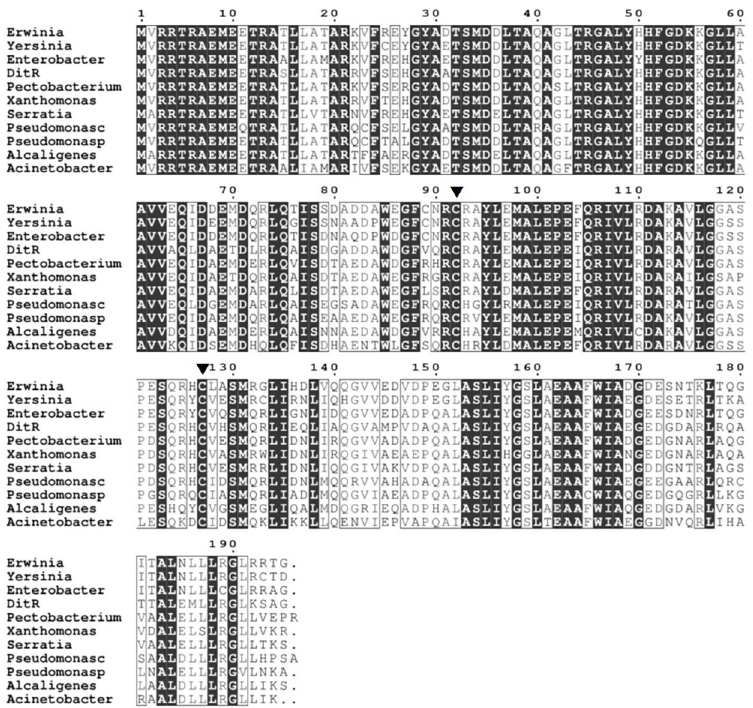
Fig 8. Multiple alignment of S . maltophilia DitR with other orthologs. Amino acid alignment was performed using Clustal omega. Arrowheads indicate the conserved cysteine residues, Cys92 and Cys127. Erwinia, Erwinia persicina